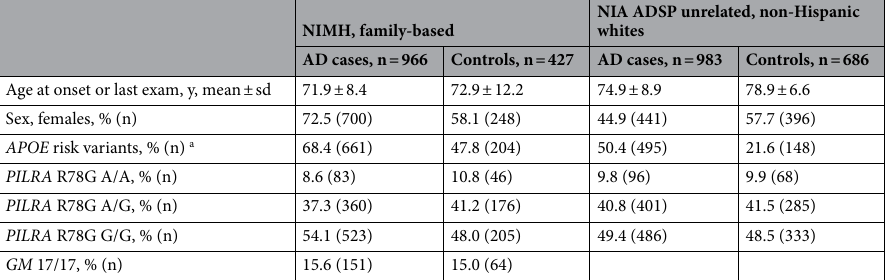
NIA ADSP unrelated, non-Hispanic whites